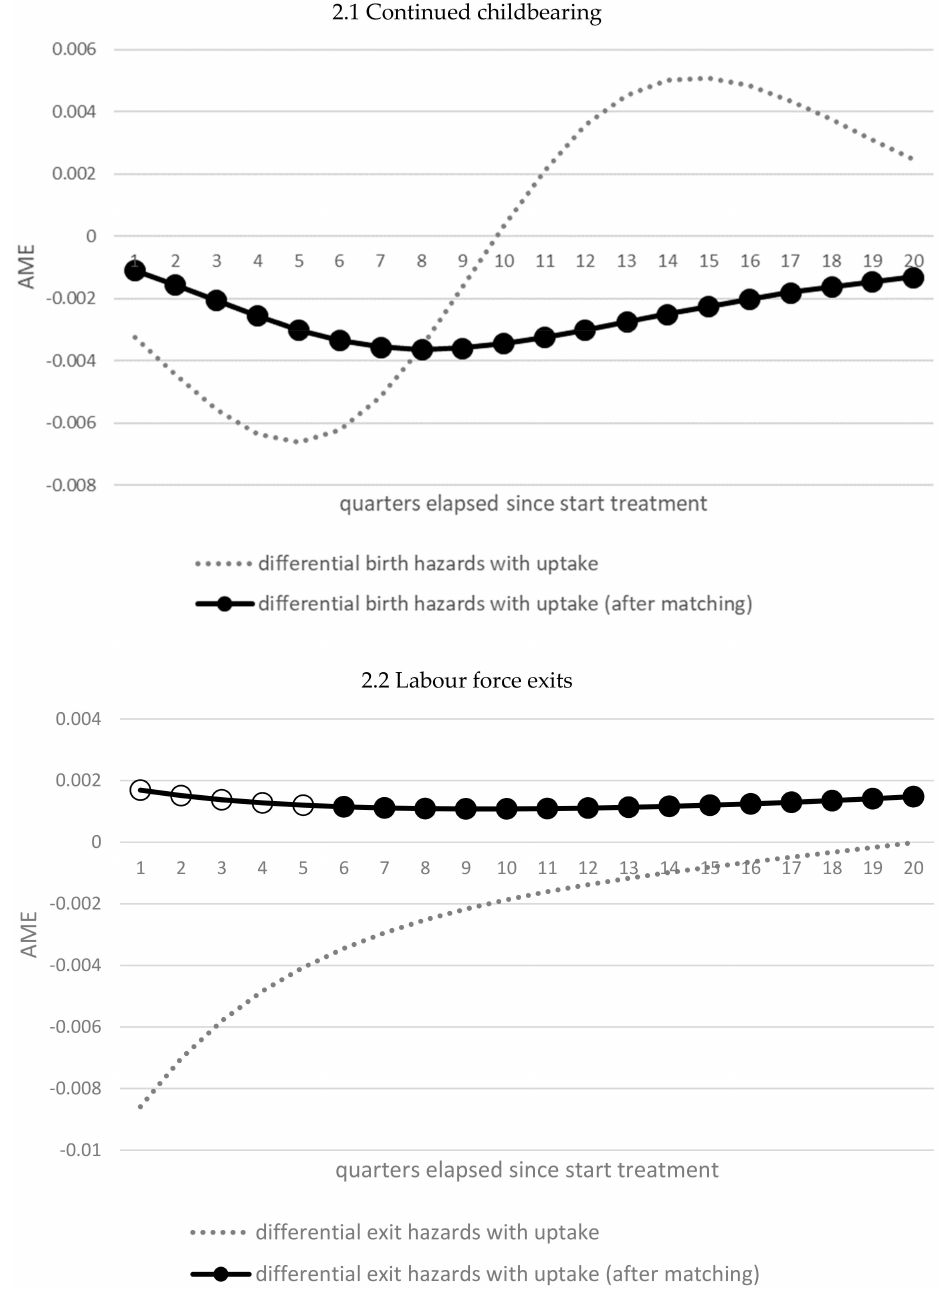
Figure 2. Di ff erential hazards (Average Marginal E ff ects (AME)) of continued childbearing (upper panel) and exiting the labour force (lower panel) after the initiation of parental leave uptake. Source data: Belgian Administrative Socio-Demographic panel (ASD